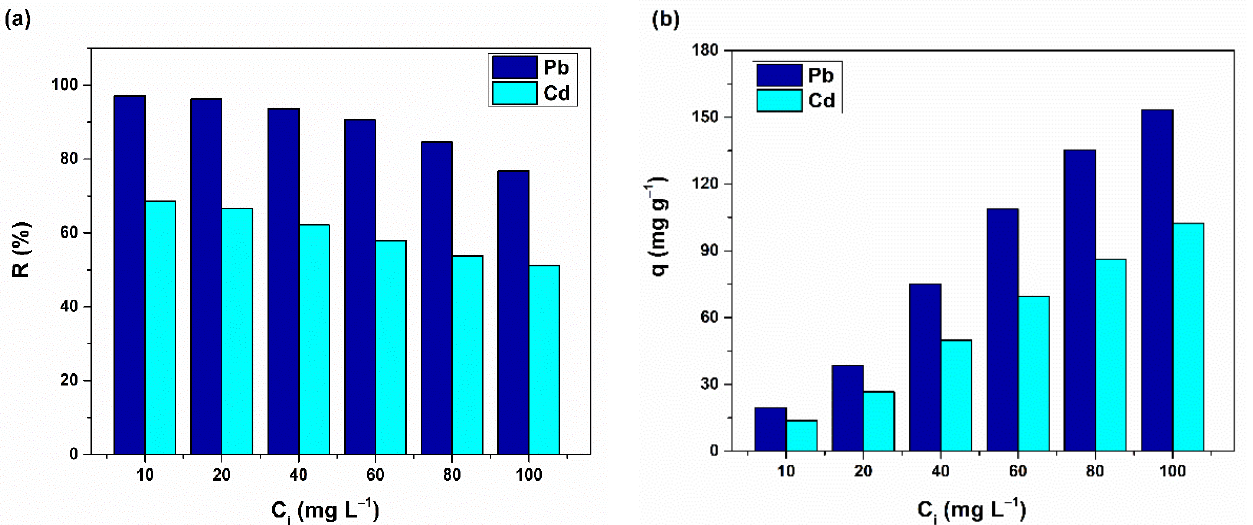
Figure 7. ( a ) Removal efficiency and ( b ) sorption capacity of CHIT-PAAA for Pb and Cd stock so- lutions.